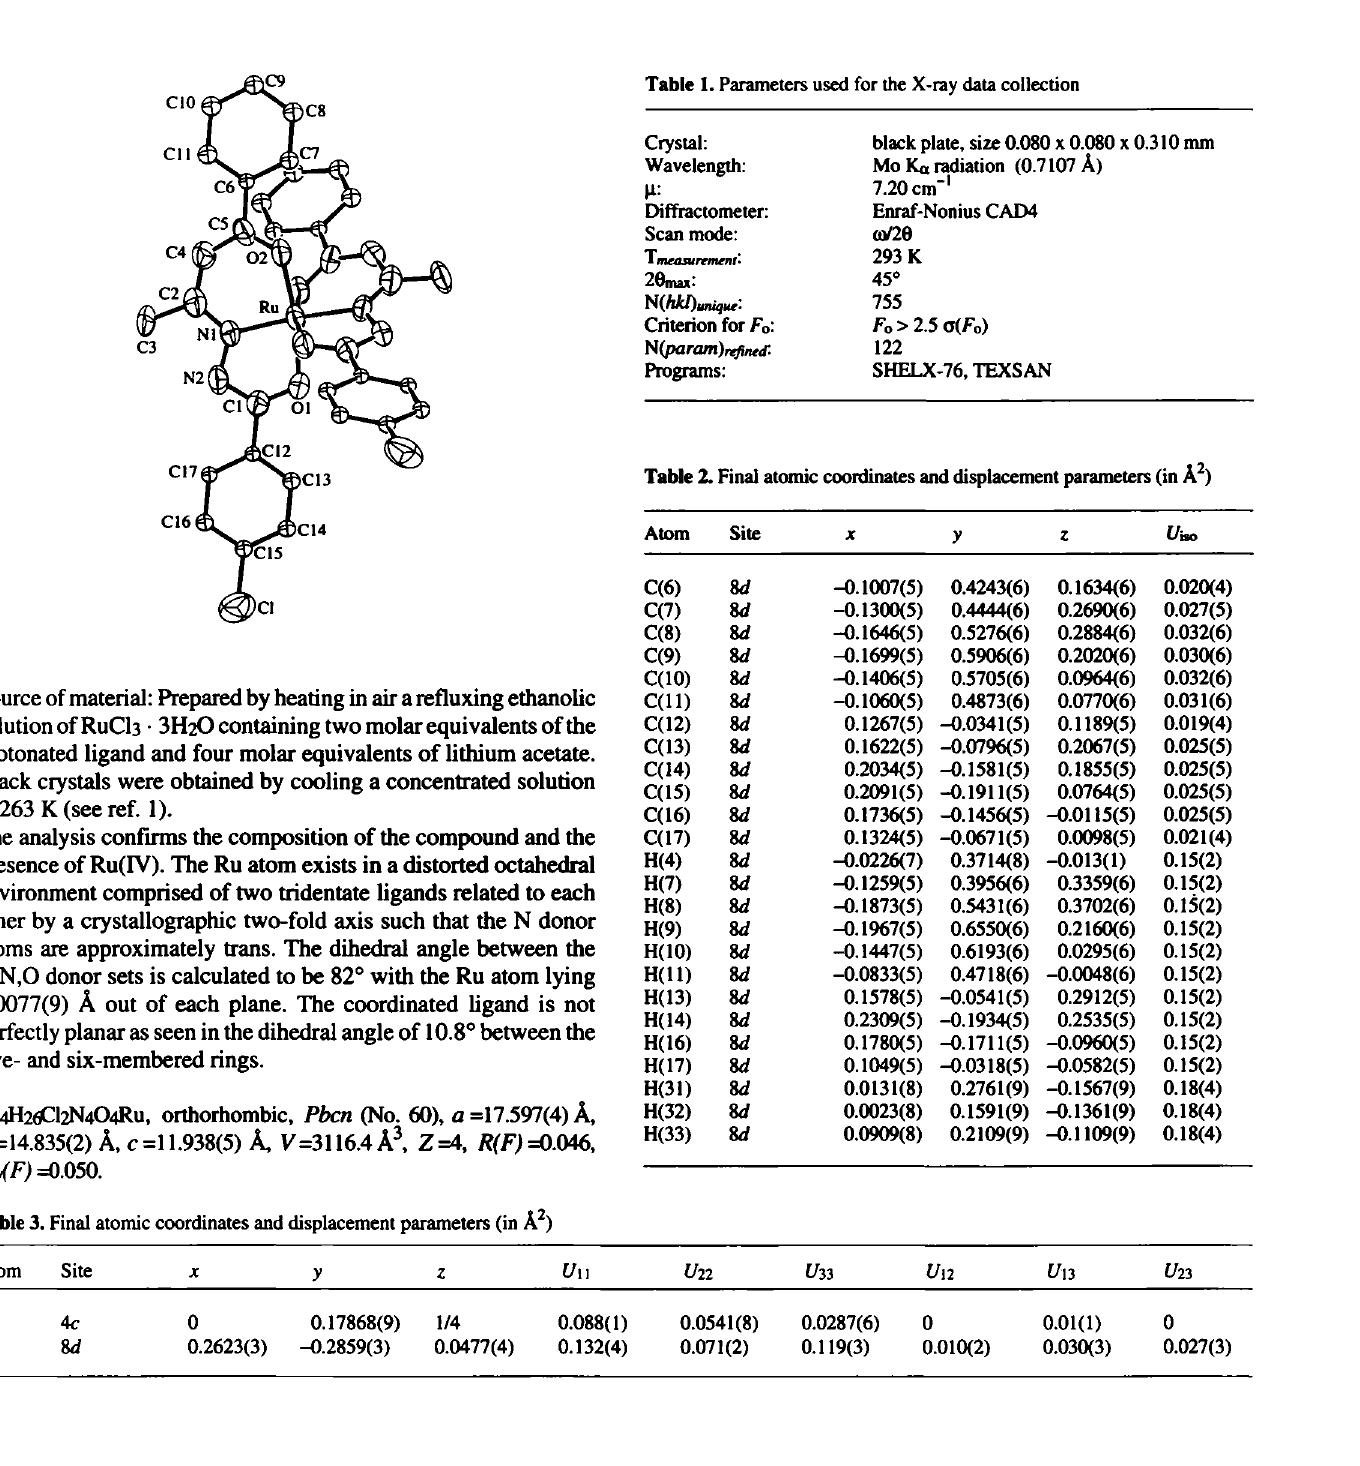
Table 1. Parameters used for the X-ray data collection